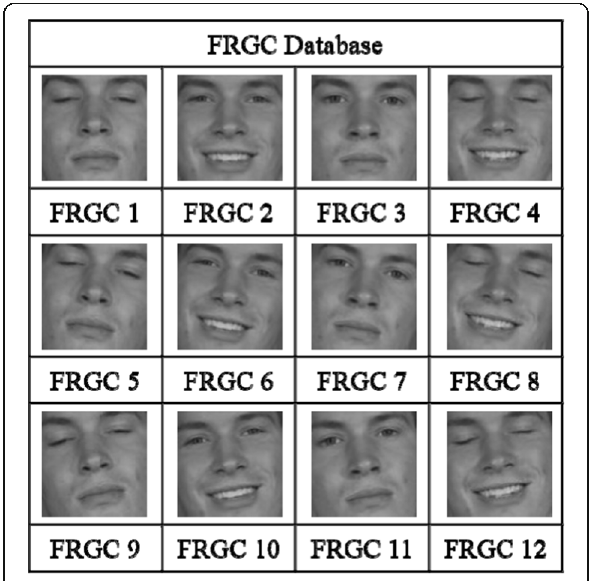
Fig. 15 Face images in FRGC database (FRGC 1 – 4) and the synthesized images (FRGC 5 – 12) for a sampled